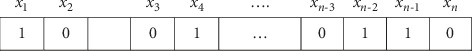
Sample of trial solution.